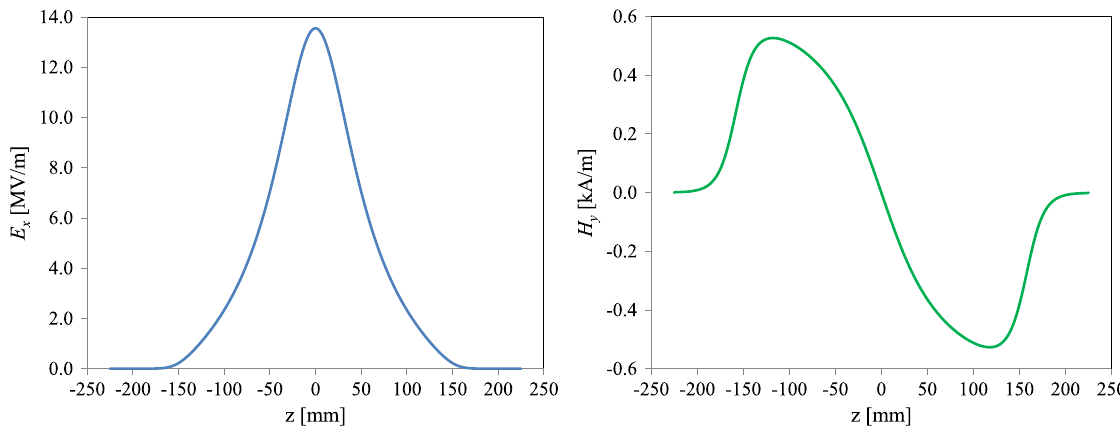
FIG. 6. Transverse electric and magnetic field components along the beam axis, at an energy content of 1 J in a 499 MHz parallel-bar cavity shown in Fig.